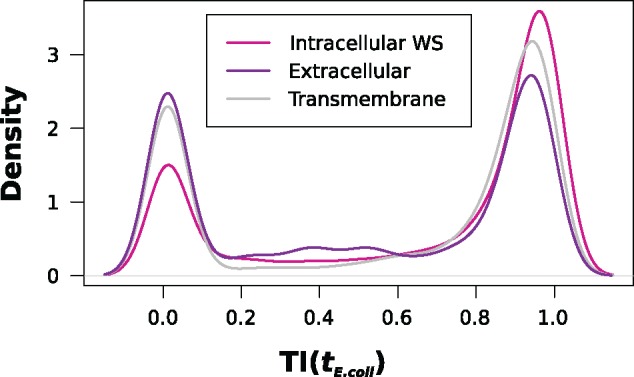
—Density plot of the TI(E. coli) for yeast proteins in dependence of their subcellular localization. Water-soluble intracellular proteins tend to have higher traceability indices in E. coli compared with proteins with a predicted extracellular localization, and to proteins localized in the cell membrane.